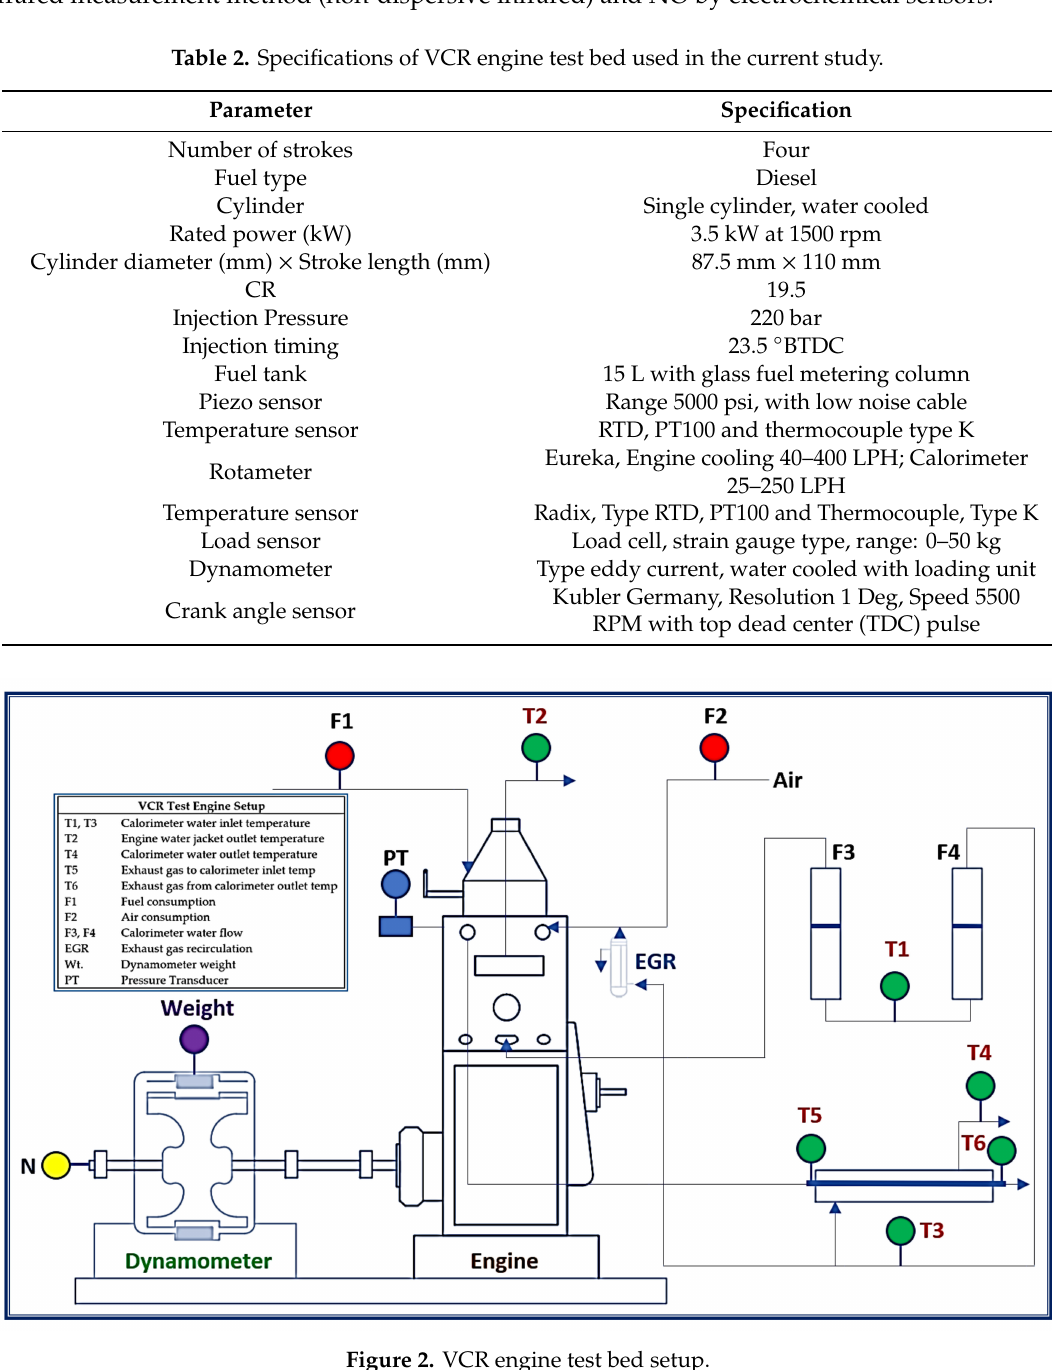
Figure 2. VCR engine test bed